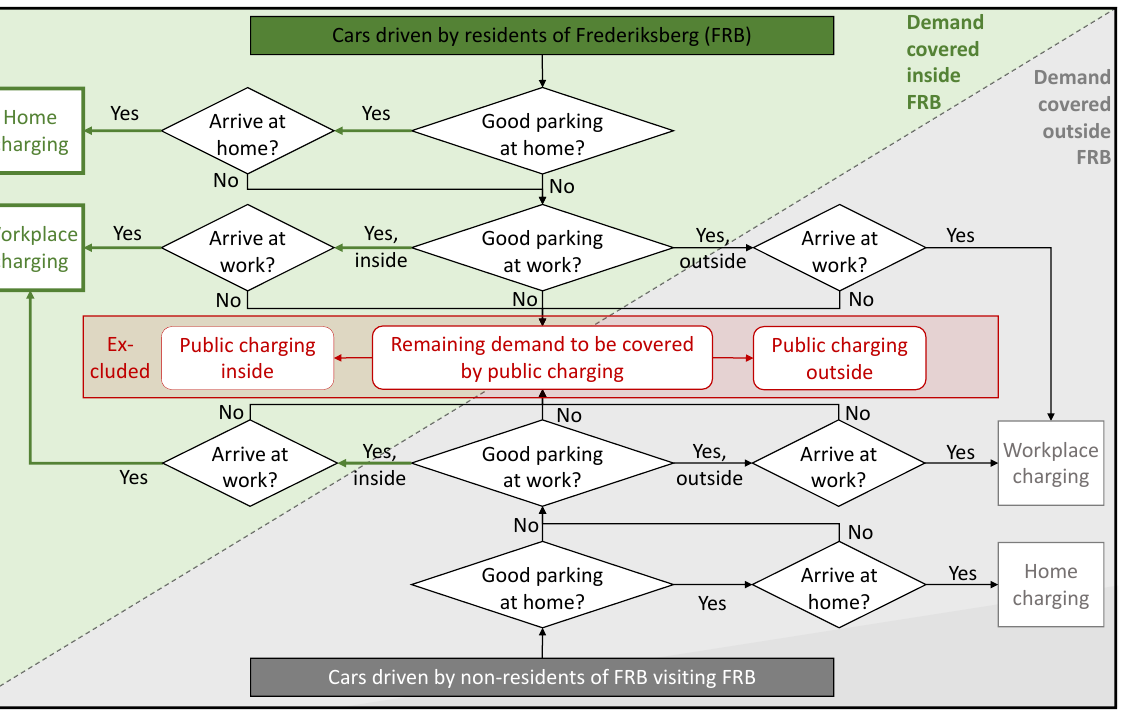
Figure 3. Representation of the segmentation of travel records according to residency and workplace municipality, as well as the parking conditions at the respective